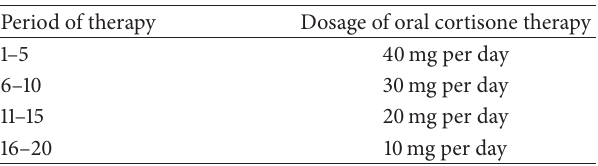
Table 2: Oral cortisone drug medication in stiff shoulder or stiff elbow